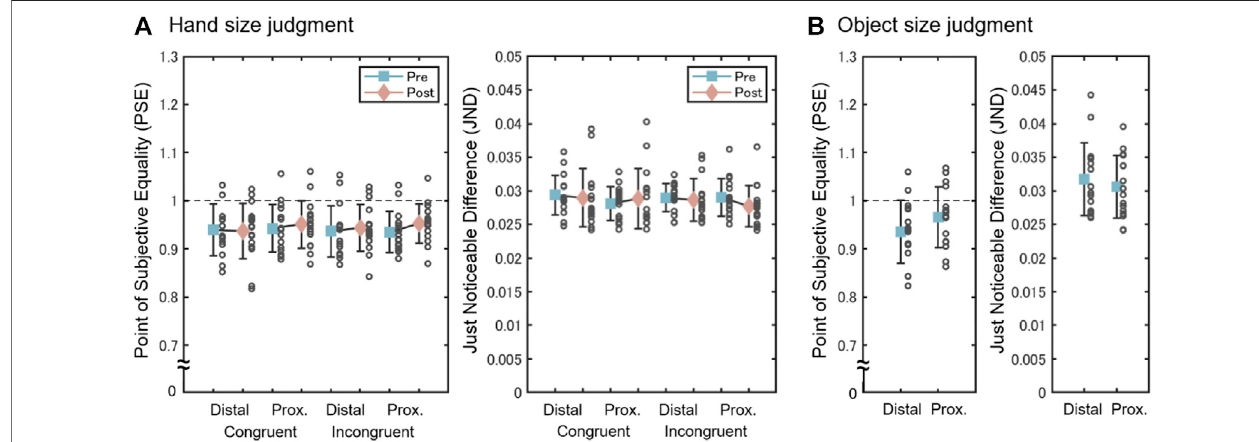
FIGURE 2 | Averaged point of subjective equality (PSE) and just noticeable difference (JND) in the hand size judgment task (A) and the object size judgment task (B) .PSEvaluessmallerthan1indicatethatparticipantsperceivedavirtualobjectassmallerthanitsactualsize(underestimation).Errorbarsindicatestandarddeviations, and small open circles indicate individual data. Prox.: